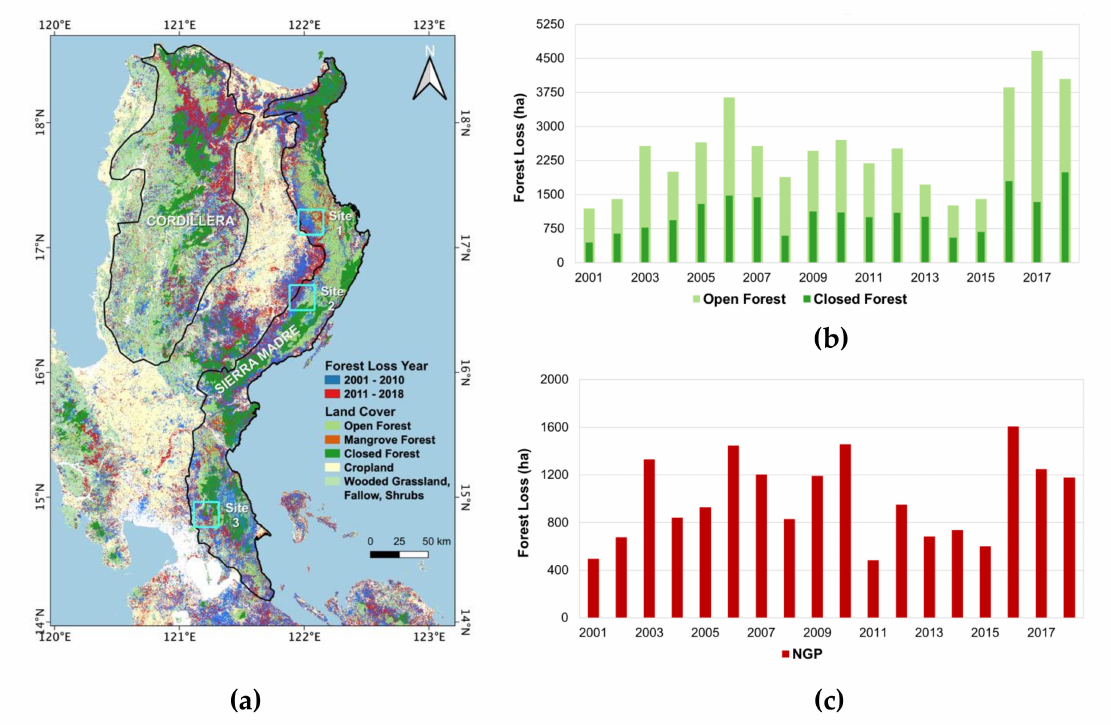
Figure 3. ( a ) Map of Northern Luzon showing the locations of the di ff erent land cover types as classified by the National Mapping and Resource Information Authority (NAMRIA), and forest losses from 2001 to 2010 (in blue) and 2011 to 2018 (in red) using Hansen et al.’s data [14]; ( b ) Annual forest losses from 2001 to 2018 in both open forest (light green) and closed forest (green); and ( c ) Annual forest losses within NGP